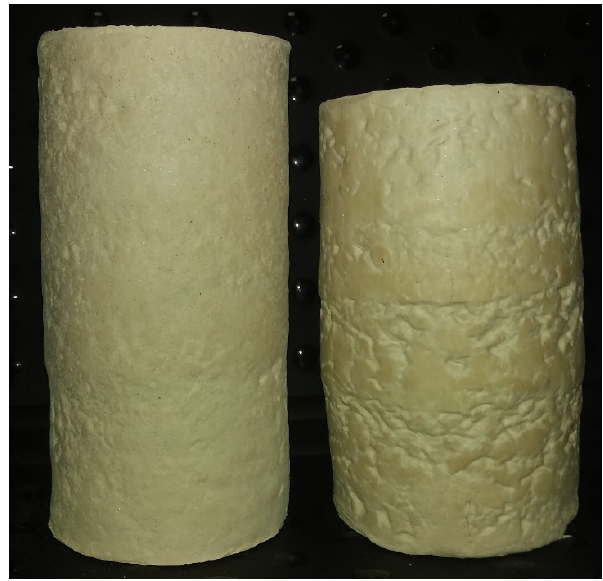
Figure 4. Image of pre- and post-testing of the samples of cohesive material.